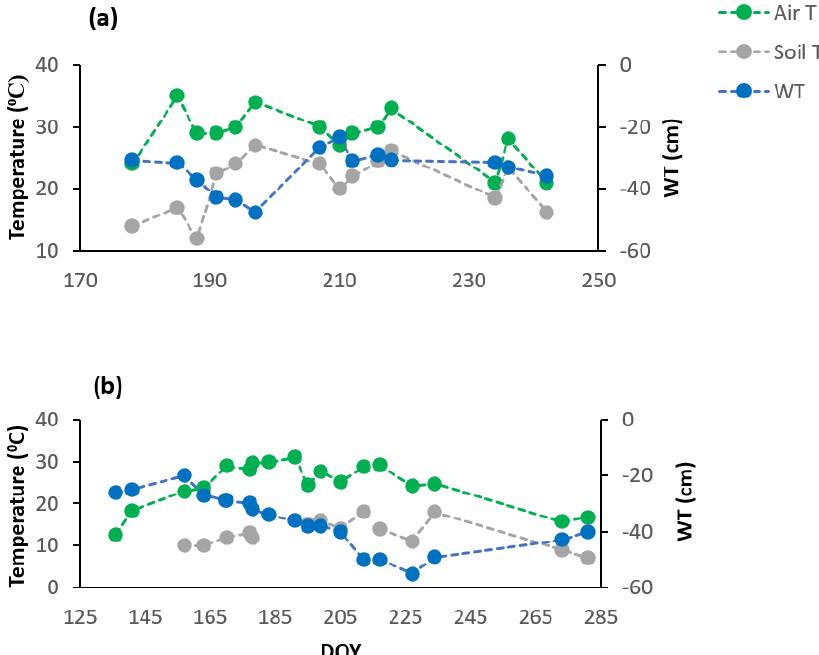
Figure 1. Environmental variables for the growing seasons of (a) 2018 and (b) 2019. Soil T is soil temperature at 10cm depth, taken manually along with WT depth, while the mean daily air temperatures (air T ) were taken from the weather station nearby.